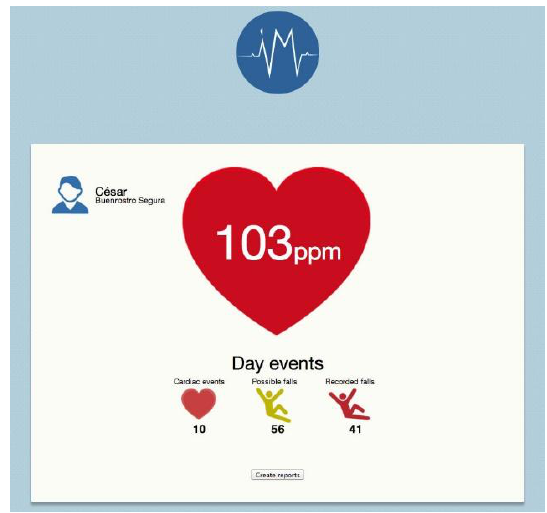
Figure 11. Web System Alert Interface.